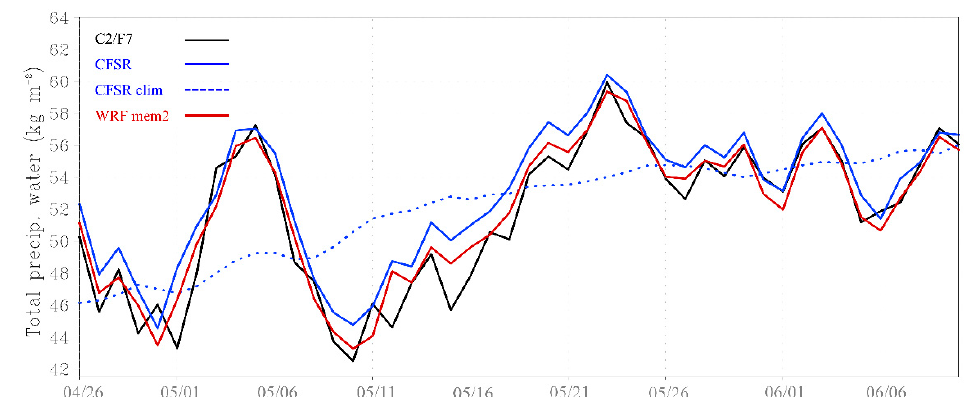
Figure 6. The daily total precipitable water in the South China Sea during 26 April–10 June 2020, retrieved with the COSMIC-2/FORMOSAT-7 RO observations (black curve), the CFSR data (blue solid curve), and the analyses of WRF Member 2 (red curve). The blue dotted curve denotes the 41-year (1979–2019) climatological average with the CFSR data.